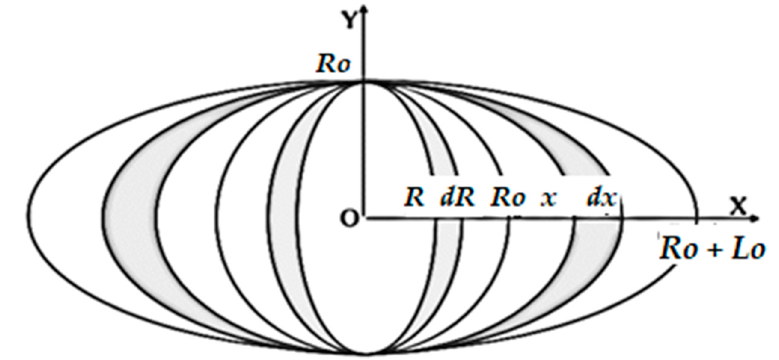
Figure 4. Length of a plasma arc in an external magnetic field [17].